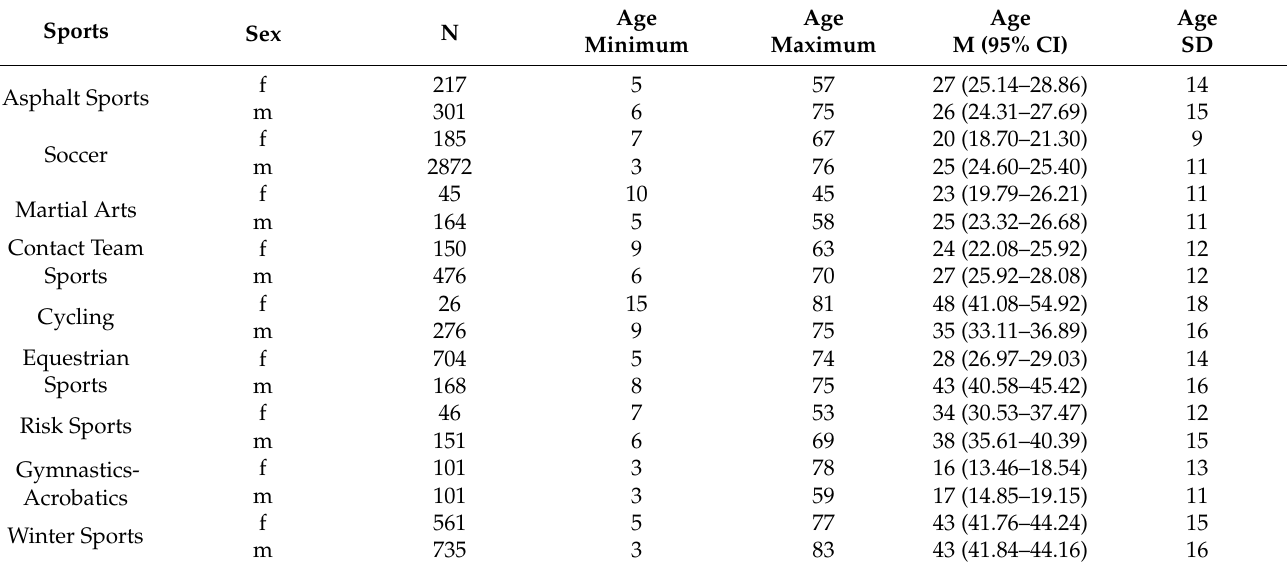
Table 1. Age of female (w) and male (m) patients, mean (M) with 95% confidence interval (95% CI), standard deviation (SD), and number of injuries